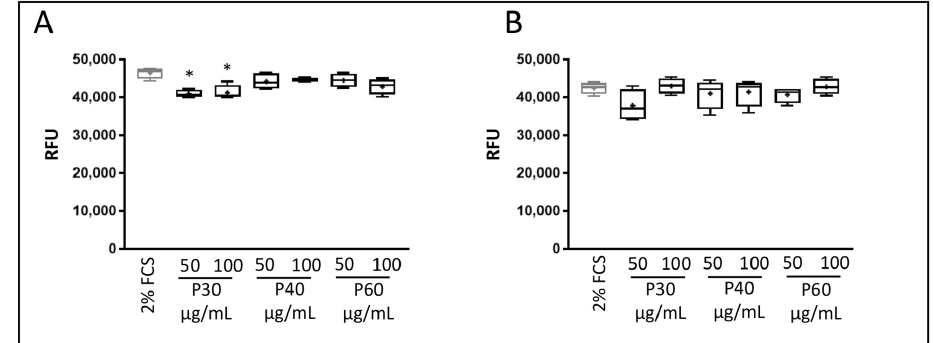
Figure 6. Effect of Promerim ® 30, 40, and 60 on the senescence of equine articular chondrocytes. Equine articular chondro- cytes were amplified and seeded at P3. At 80% of confluency, the cells were treated with Promerim ® 30, 40, and 60 at two concentrations (50 and 100 µ g/mL) in the presence of 2% fetal calf serum (FCS) and then cultured for 72 h in hypoxia ( A ) and normoxia ( B ). Controls with 2% FCS were performed. The levels of β -galactosidase were measured 3 days post-treatment. Data are represented as box plots ( n = 4). Statistical analyses were based on the Mann–Whitney test (* p < 0.05) and the 2% FCS condition was used as a reference. P30, P40 and P60: Promerim ® 30, Promerim ® 40, and Promerim ®